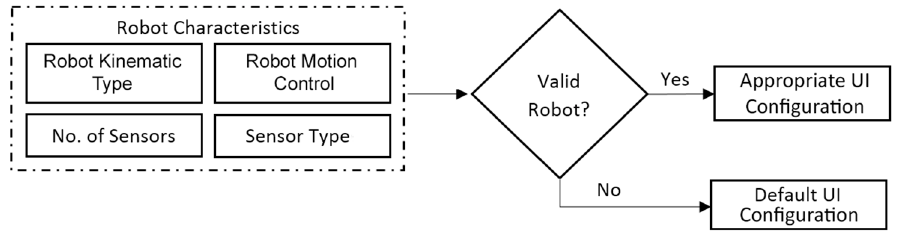
Figure 4. Flowchart overviewing the Matlab toolbox teleoperation UI configuration assignment based on robot characteristic.